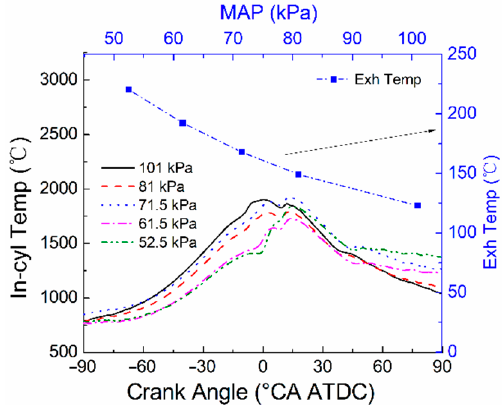
Figure 9. The in-cylinder temperature under various